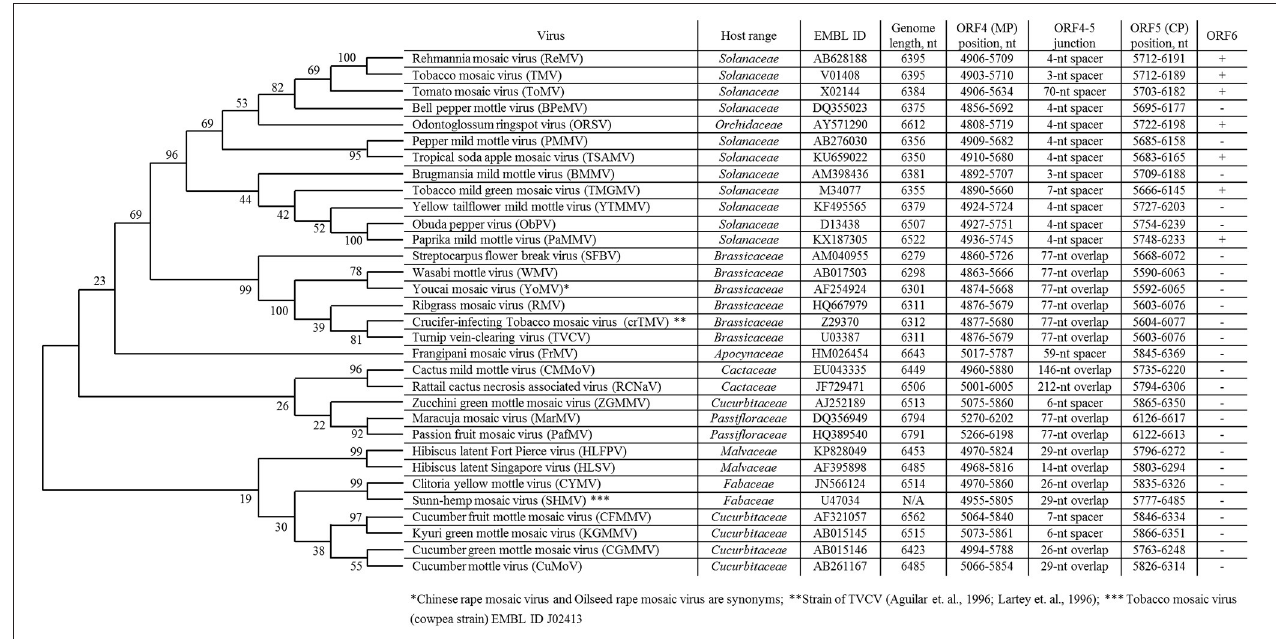
FIGURE 1 | List of overlapping tobamovirus MP/CP genes and tobamovirus molecular phylogenetic analysis based on amino acid sequences of CP proteins using the maximum likelihood method using the JTT matrix-based model (Jones et al., 1992). Evolutionary analyses were conducted in MEGA7 (Kumar et al.,